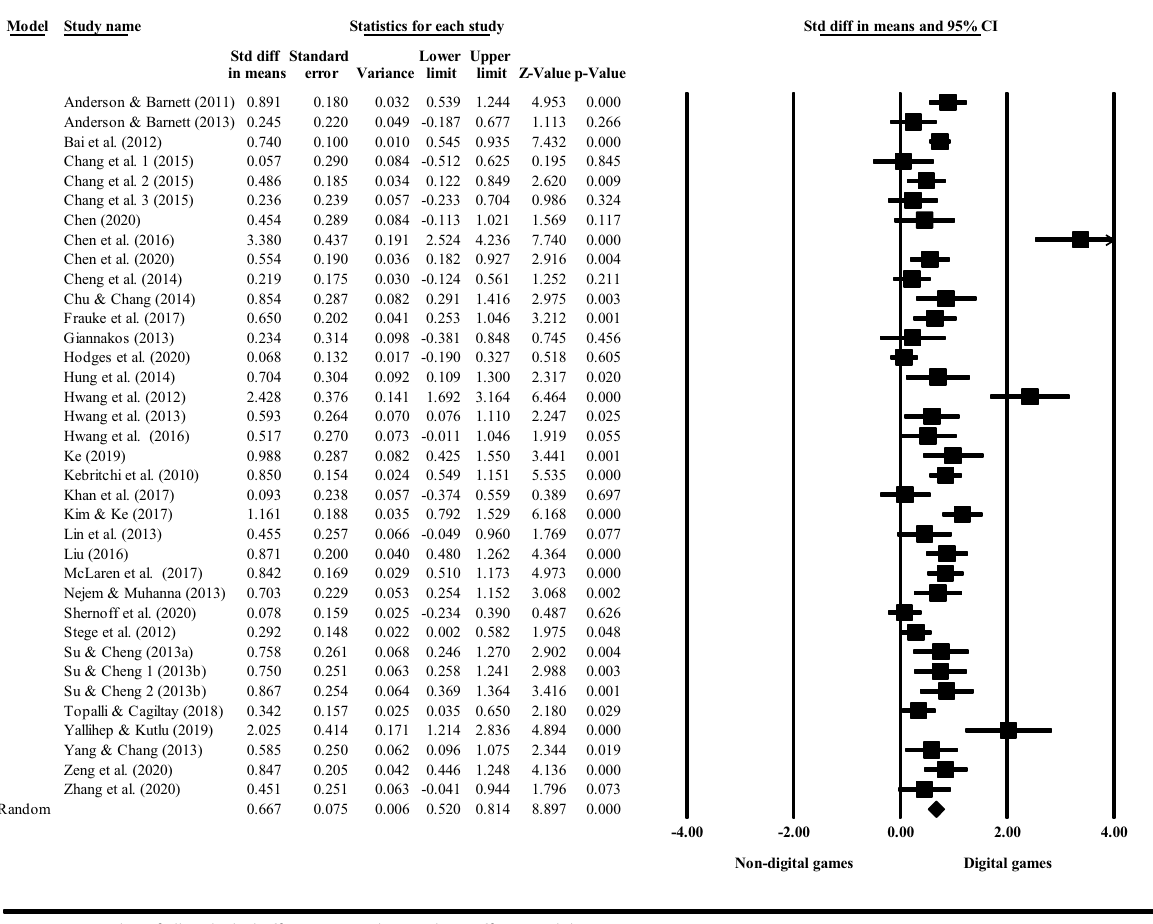
Fig. 3 Forest plot of all included effect sizes in the random‑effect